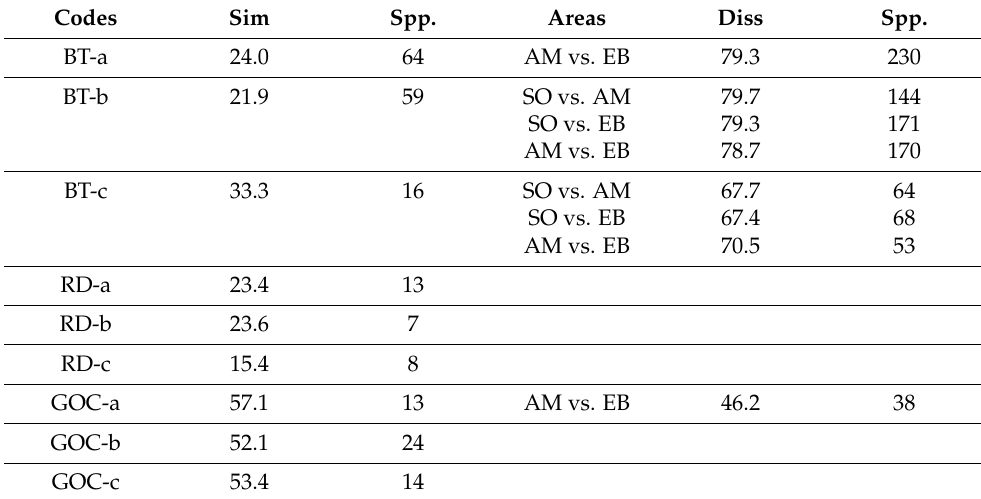
Table 3. Summary of SIMPER results of the assemblages (see codes in Figure 7) identified from multi-variant analysis of beam trawl (BT), rock dredge (RD), and experimental bottom trawl (GOC) samples obtained in sedimentary and rocky bottoms of the Ses Olives (SO), Ausias March (AM), and Emile Baudot (EB) seamounts and adjacent area of the Mallorca Channel (Balearic Islands, western Mediterranean), showing the percentage of within-group similarity (Sim) and the number of species (Spp.) contributing up to 90% to this similarity. The percentage of between-group dissimilarity (Diss) comparing geographic differences (by seamount) in the identified beam trawl sample assemblages as well the number of species (Spp.) contributing up to 90% to this dissimilarity, is also shown. Codes Sim Spp. Areas Diss Spp. BT-a 24.0 64 AM vs. EB 79.3 230 BT-b 21.9 59 SO vs.